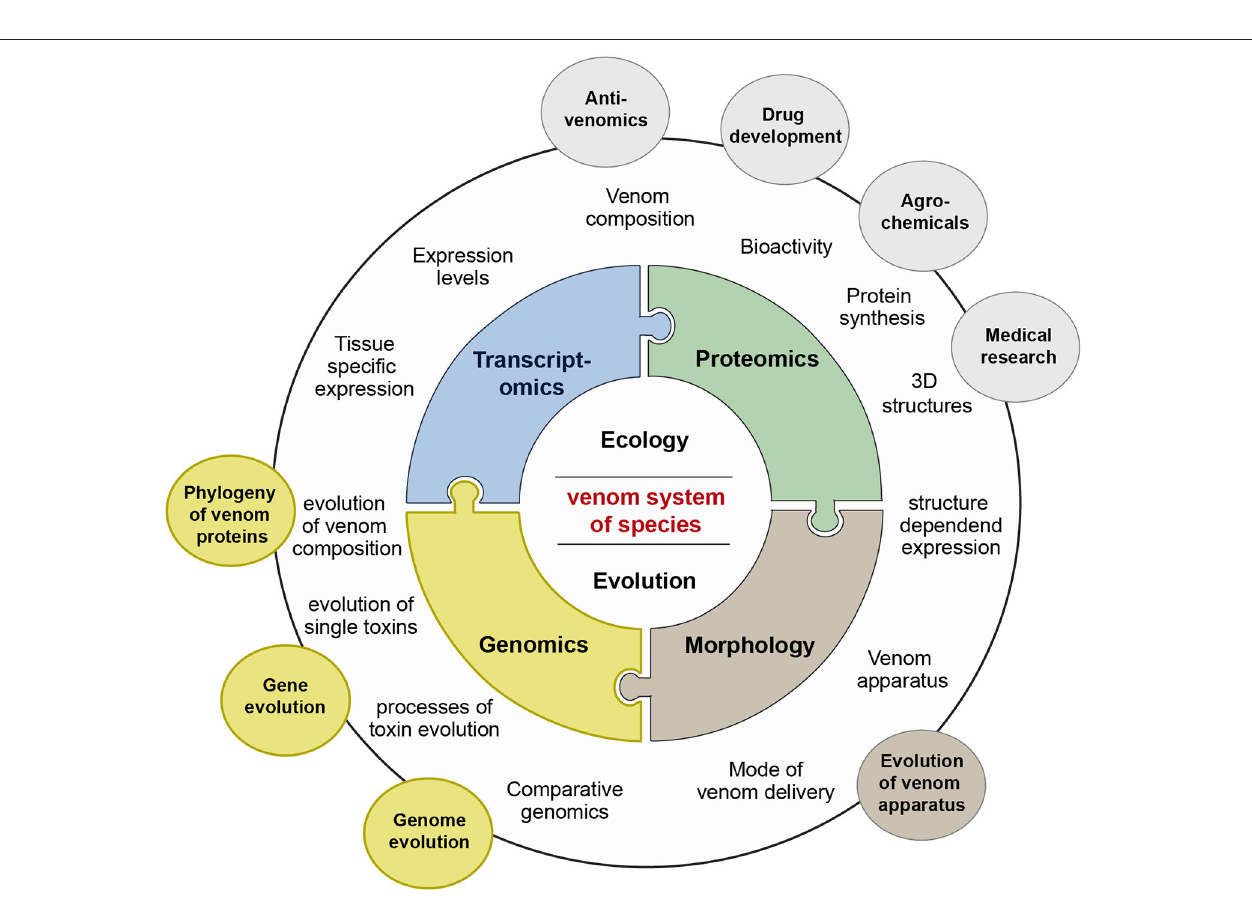
FIGURE 1 | the context of venom evolution are shown in the yellow boxes. For the few venomous groups that are studied in more depth (underlined) gray boxed illustrate the overall number of available genomes according to the NCBI database (asterisk*, see also Supplementary Table 1 ) and recent publications (Branstetter et al., 2018; Garb et al., 2018). Animal silhouettes were taken from PhyloPic (PhyloPic — Free Silhouette Images of Life Forms) or were generated on own photograph, the phylogeny is based on Casewell et al. (2013).